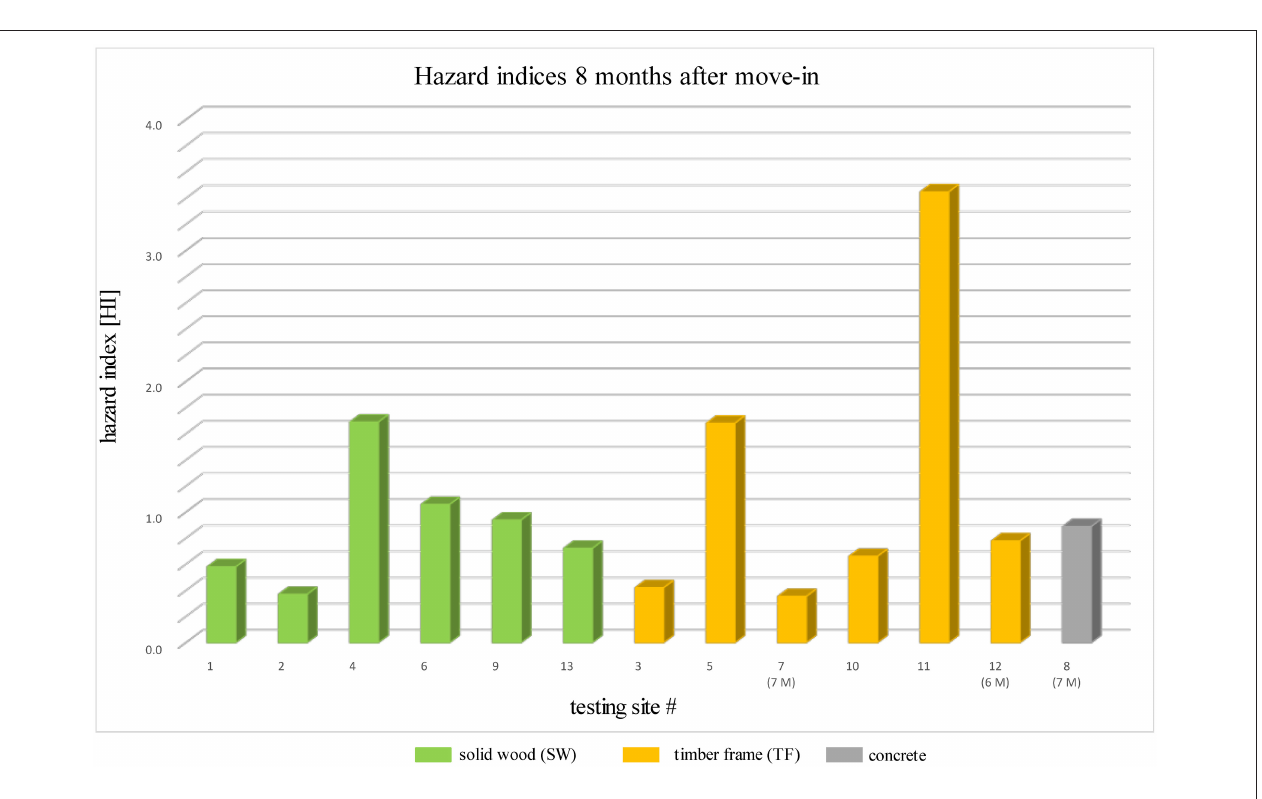
FIGURE 4 | Hazard indices 8 months after